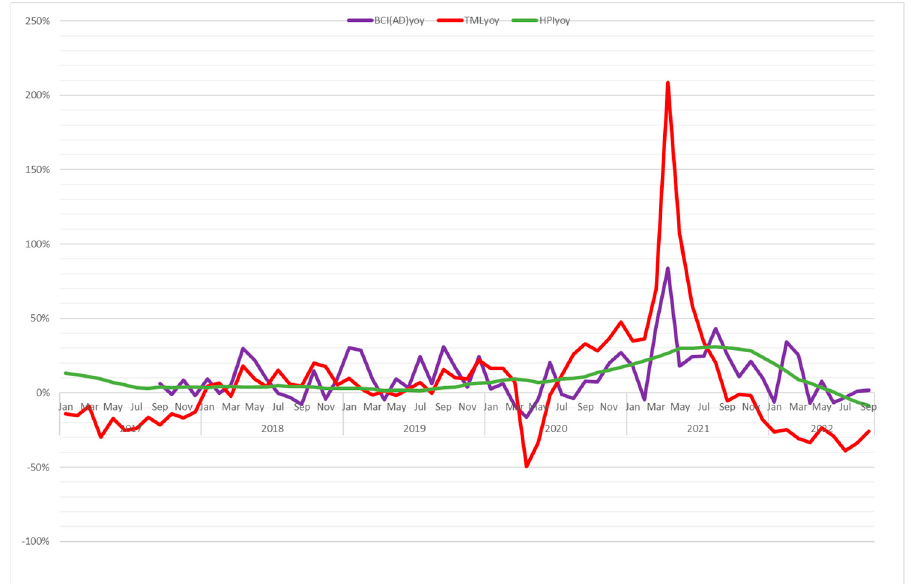
Figure 2. Year-on-year change of building consents issued for all dwellings (BCIyoy), year-on-year change of total mortgage lending (TMLyoy), and year-on-year change of the house price index (HPIyoy) of New Zealand, January 2017–September 2022. Sources: RBNZ (2022b), REINZ (2022), StatsNZ